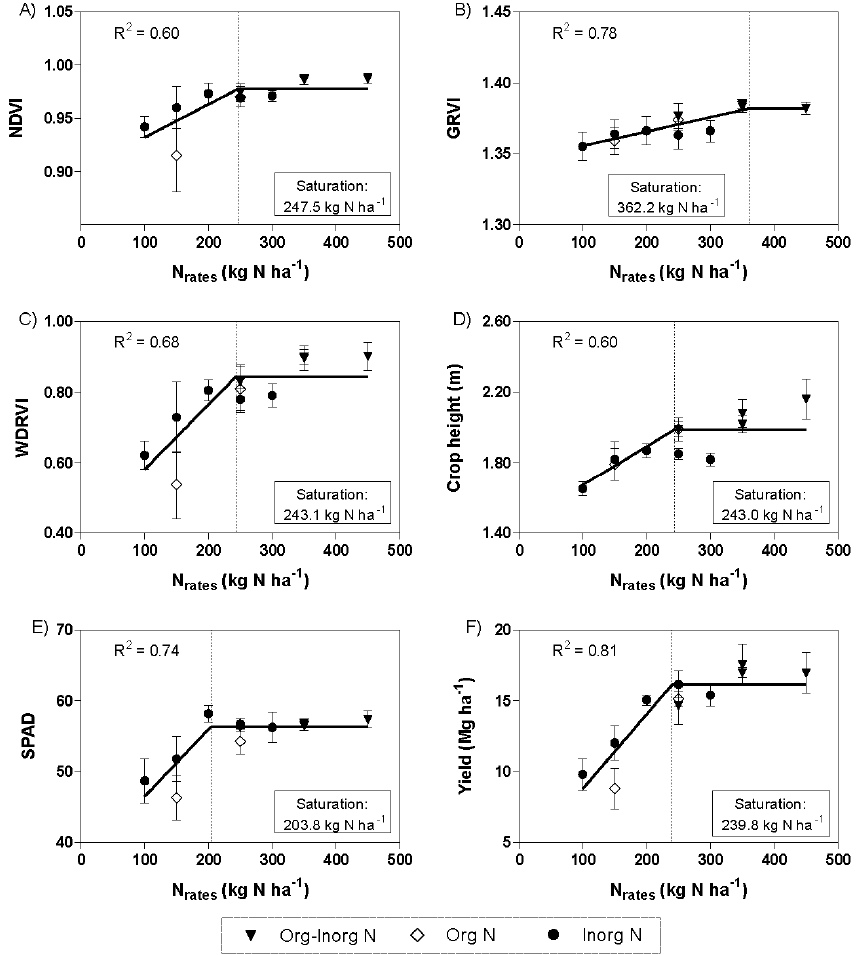
Figure 4. Response of ( A ) NDVI; ( B ) GRVI; ( C ) WDRVI vegetation indices; ( D ) crop height at V12; ( E ) SPAD at VT; and ( F ) grain yield to different N fertilization treatments. Saturation N dose is determined when there is no response to higher N fertilization (predicted economic optimum rate of fertilization). Organic, inorganic and combined organic-inorganic treatments are represented with different symbols. N0 and N400 treatments were not included in the analysis.